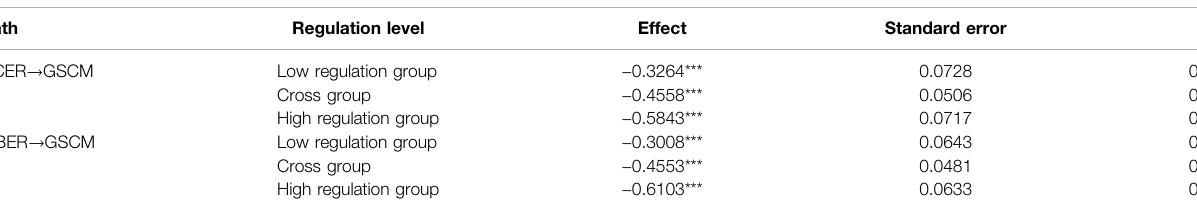
TABLE 8 | Regulating effect test